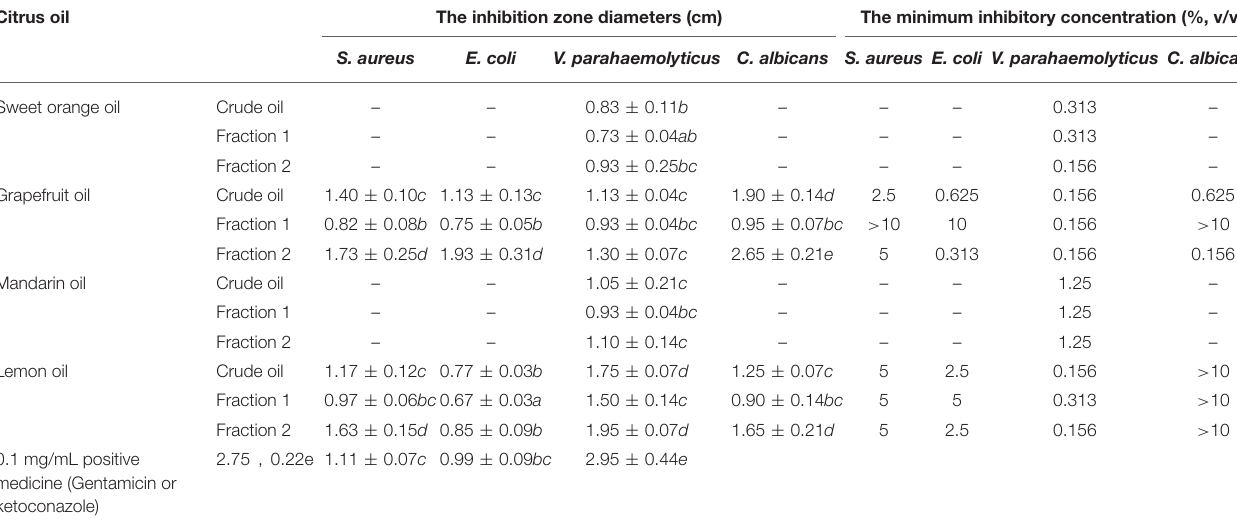
TABLE 3 | The inhibition zone diameters and minimum inhibitory concentrations of citrus EOs against Staphylococcus aureus , Escherichia coli , Vibrio parahaemolyticus , and Candida albicans